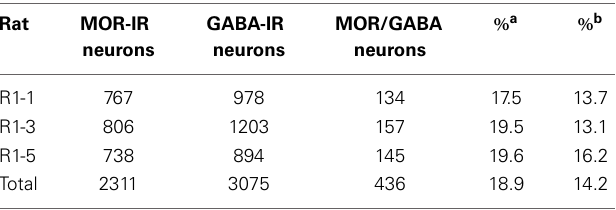
a The percentage of MOR/GABA double-labeled neurons to the total number of MOR-IR neurons; b The percentage of MOR/GABA double-labeled neurons to the total number of GABA-IR neurons.